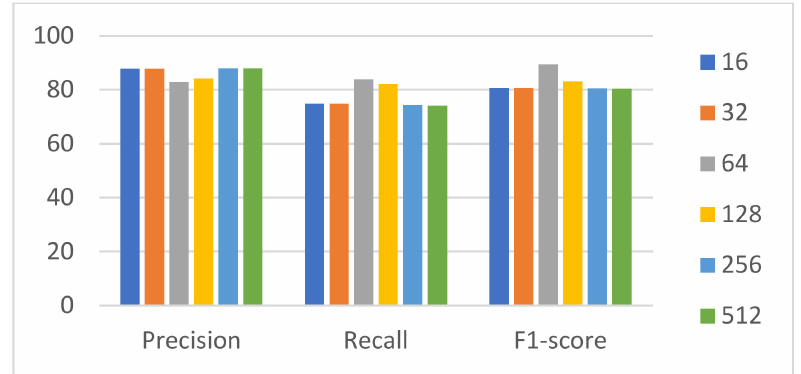
Figure 14. Training metrics for different batch sizes.